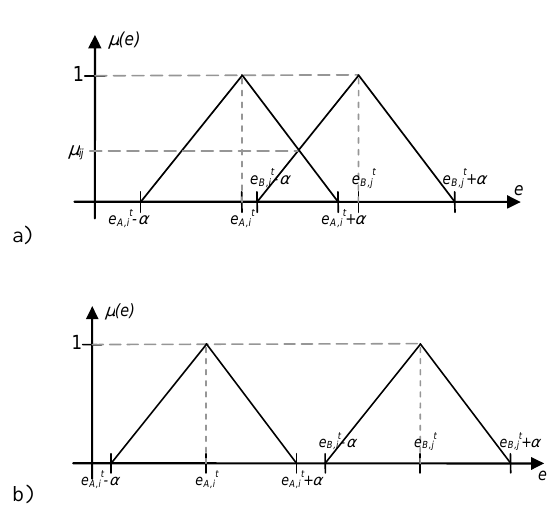
Fig. 7. Calculation of the compatibility degree for matching component values of energy signatures of molecules A and B (a). Mismatching energy components (b).